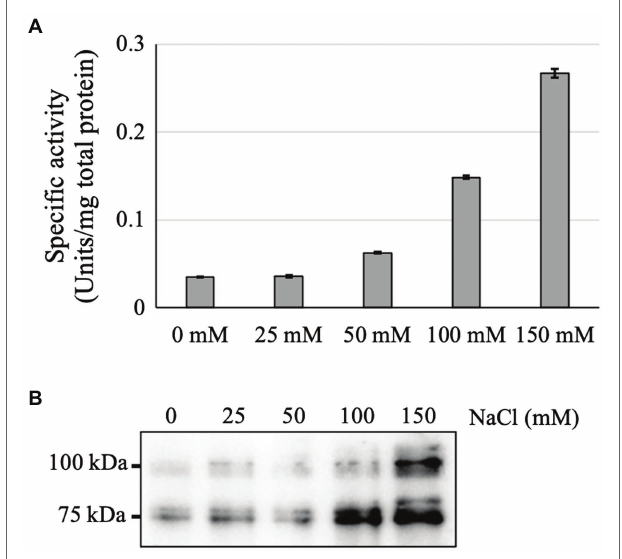
FIGURE 5 | Effects of NaCl supplementation on intracellular GAA production. (A) Intracellular GAA-specific activity in cultures supplemented with various amounts of NaCl (0–150 mM). (B) Western blot of crude intracellular proteins of NaCl-supplemented 11-day-old culture cells. The result of CBB staining as a loading control is shown in Supplementary Figure 2